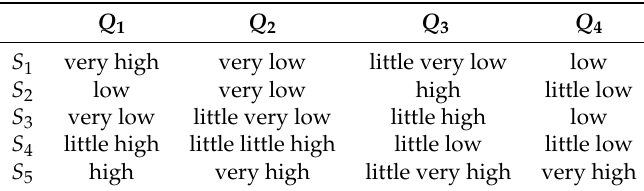
Table 1. Testimonials of experts on the objective function. Q 1